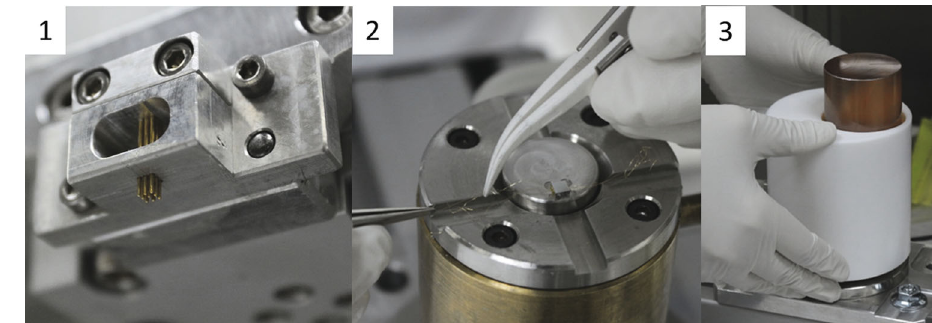
Fig. 10 Sensor gluing: (1) Matrix of spring-loaded tips used for the 3 × 2.8 × 1 mm 3 NTDs. (2) Placing NTD on the positioning device and held by vacuum. The Spring-loaded tip matrix is lowered on the NTD after dipping in the glue. After that, (3) the ZnSe crystal is placed on the top of the NTD and it is kept in place by a PTFE